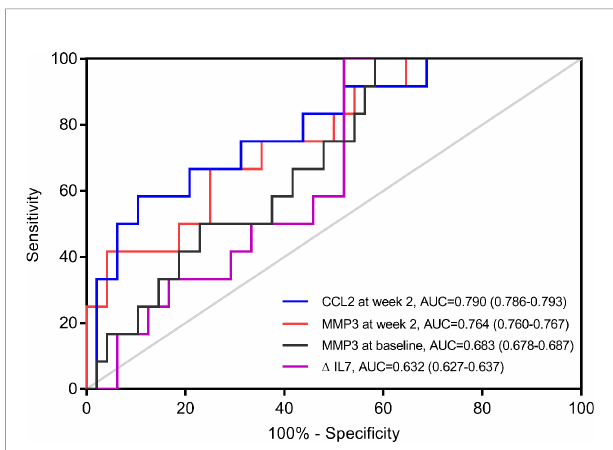
FIGURE 2 | Receiver operating characteristics (ROC) analyses of potential predictors in cohort 1. ROC Curve of change of IL-7 from baseline to week 2 ( D IL-7), matrix metalloproteinase (MMP) 3 at baseline, MMP3 at week 2 and C-C motif ligand (CCL) 2 at week 2 for predicting primary non-response (n=12) in cohort 1 (n=60).